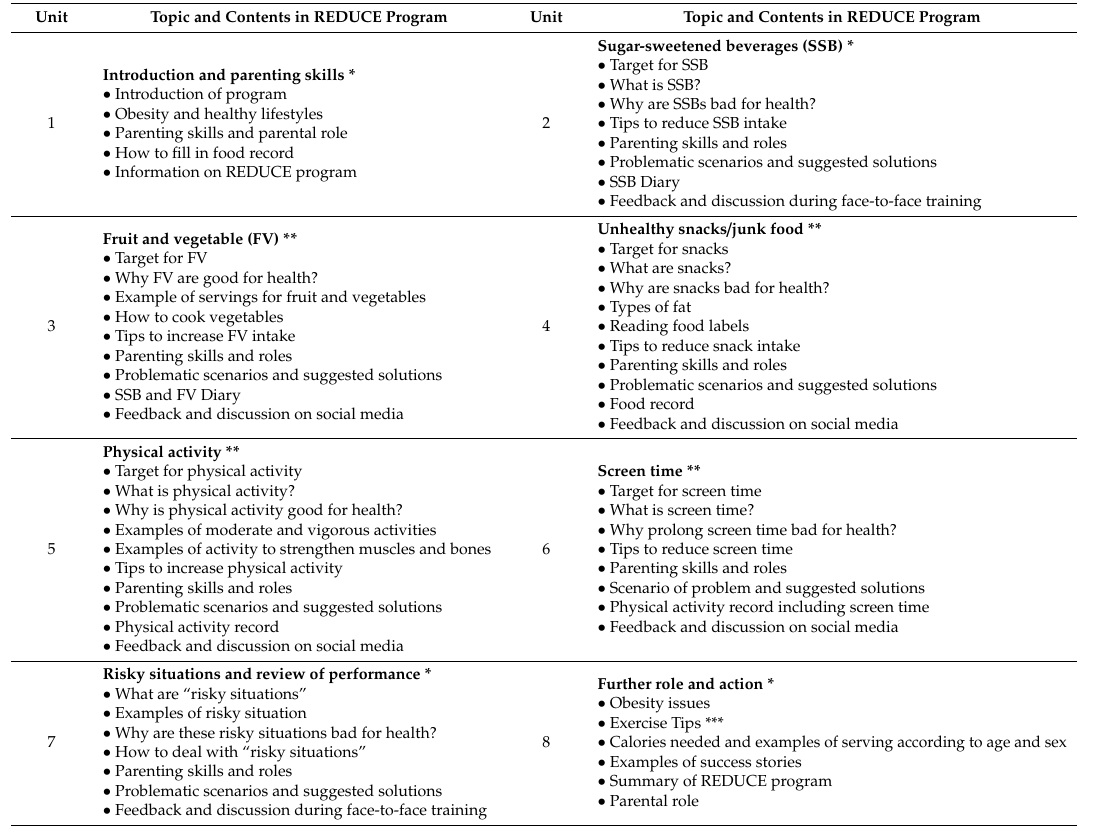
Table 1. Contents of REDUCE (REorganise Diet, Unnecessary sCreen time and Exercise) module which were delivered over a four-week period for the intervention